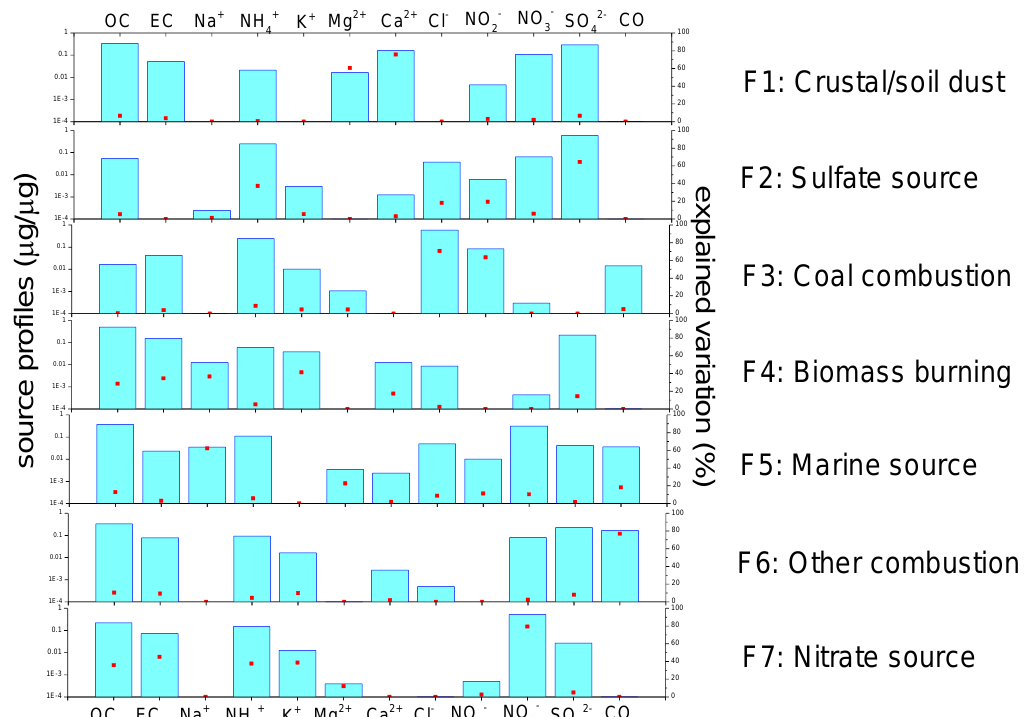
Figure 3. Simulated source profiles (blue bars, in units of μg/μg) and explained variations (red squares, in units of %) of PM 2.5 species via PMF(Positive Matrix Factorization).